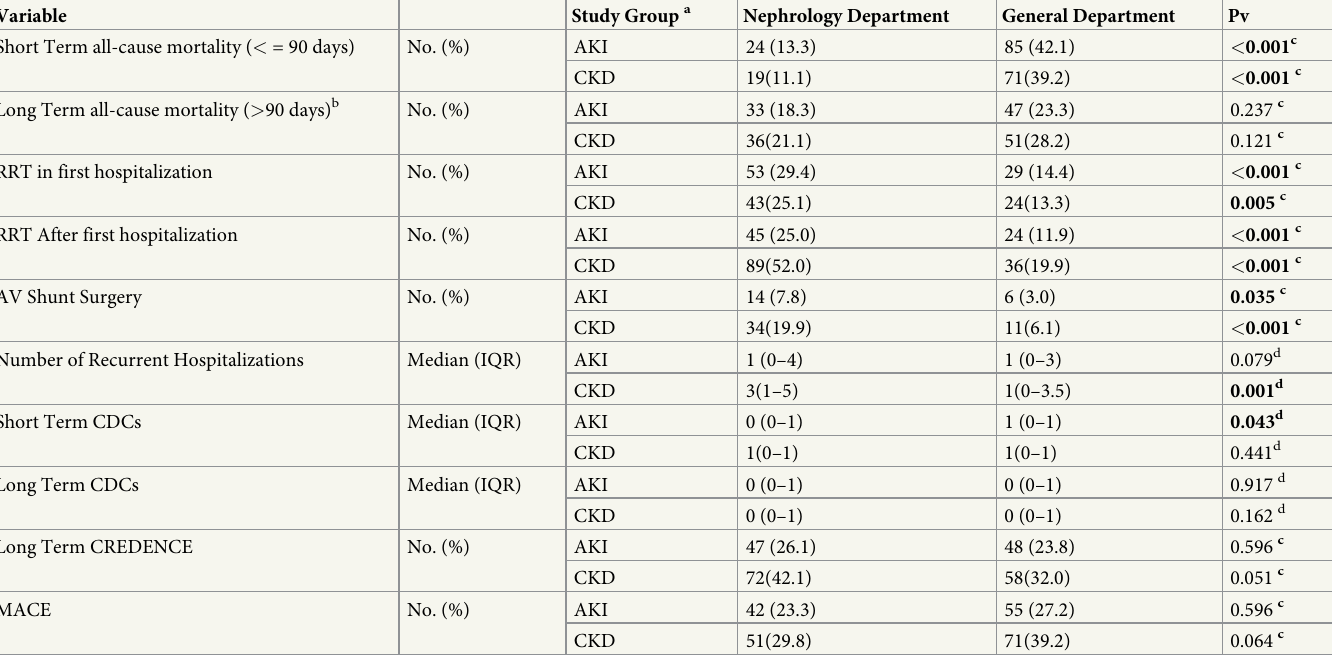
Table 2. Association between department type and clinical outcomes, univariate